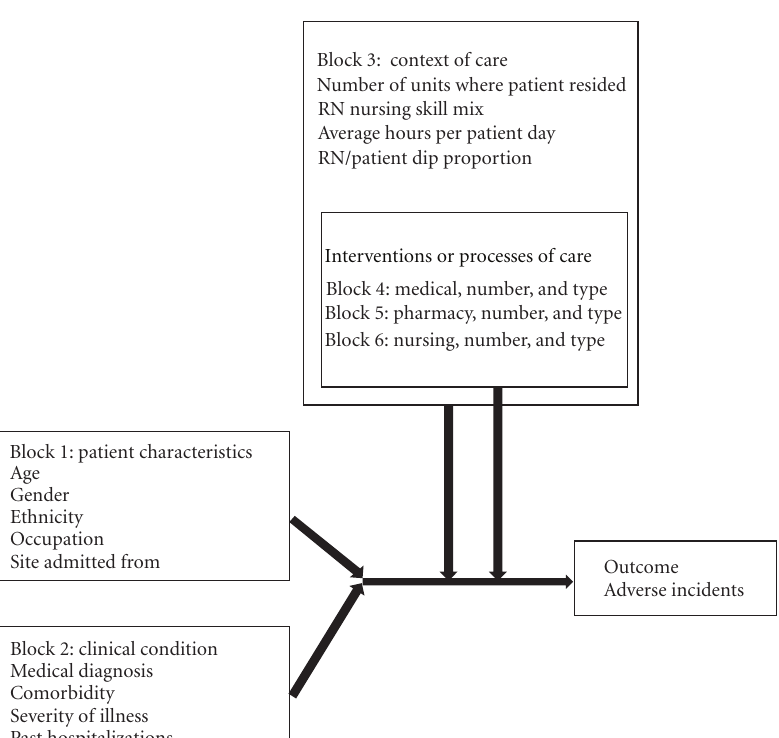
Figure 1: Model for predicting adverse incidents in the